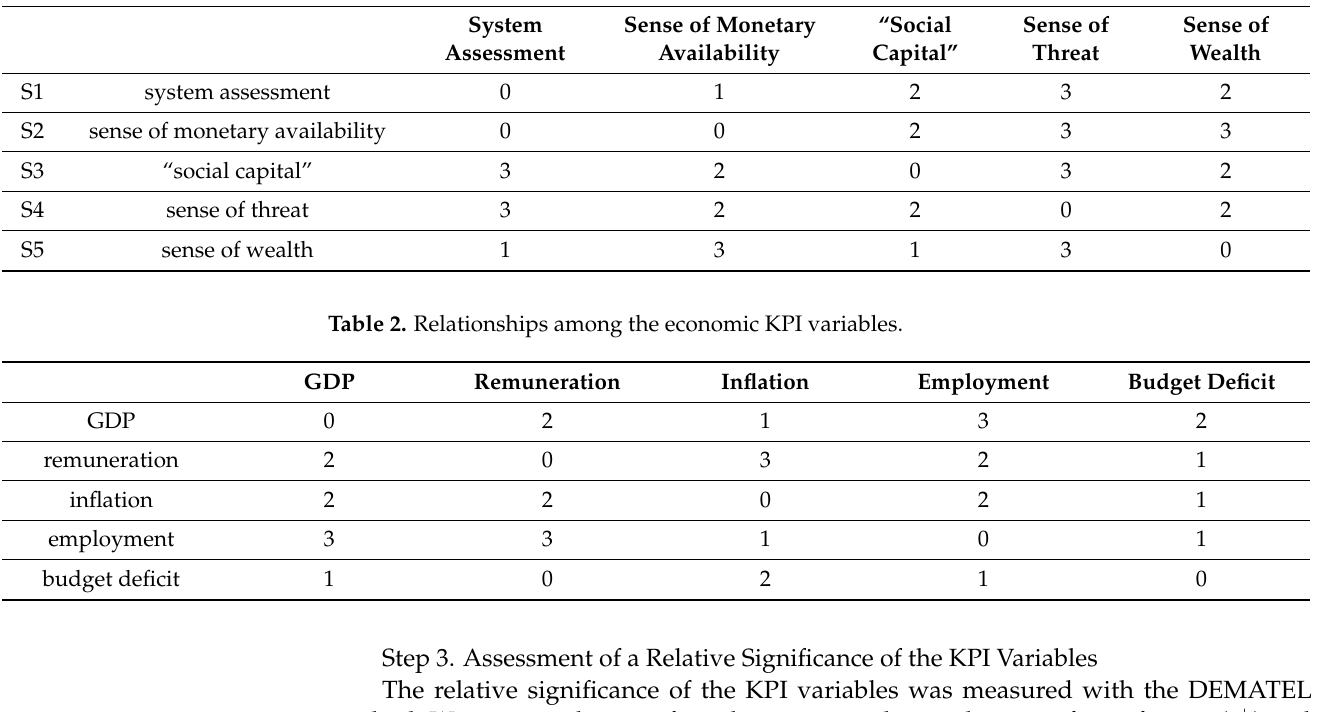
Table 1. Relationships among the social KPI variables. S1